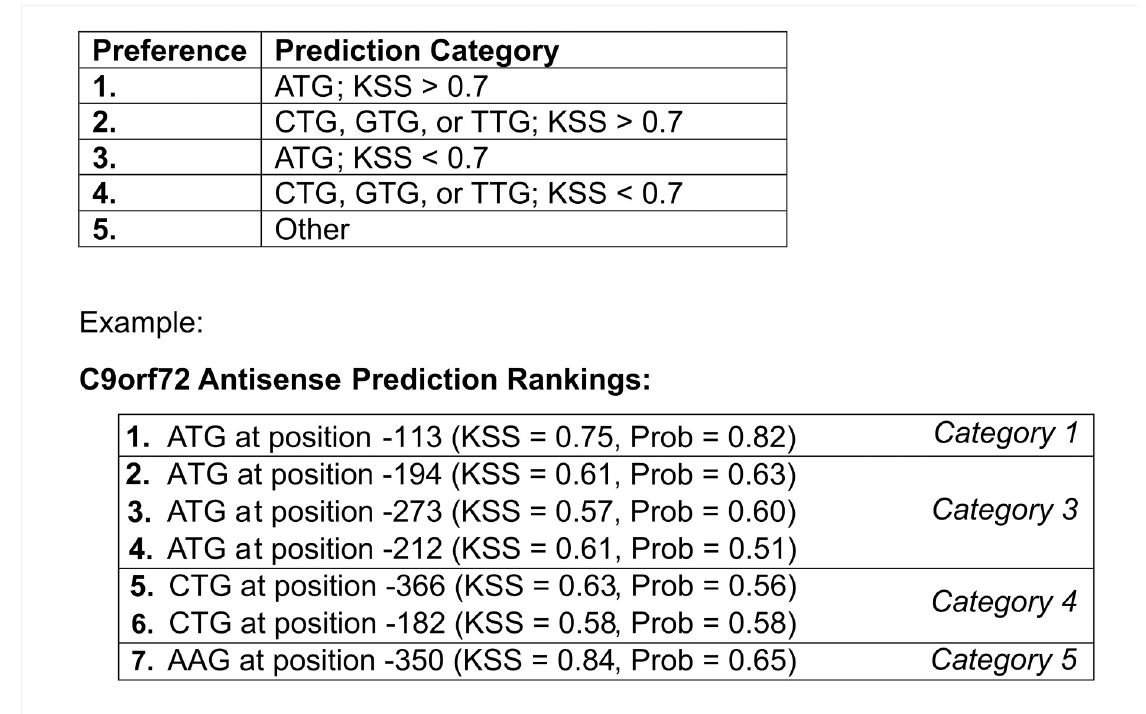
Fig 14. Proposed order of best predictions. We suggest categorizing predictions based on the above table, and then ordering them by category (1–5, with 1 most preferred). Predictions in the same category are to be sorted by either KSS or RFC probability. We show the ranking of C9orf72 antisense predictions as an